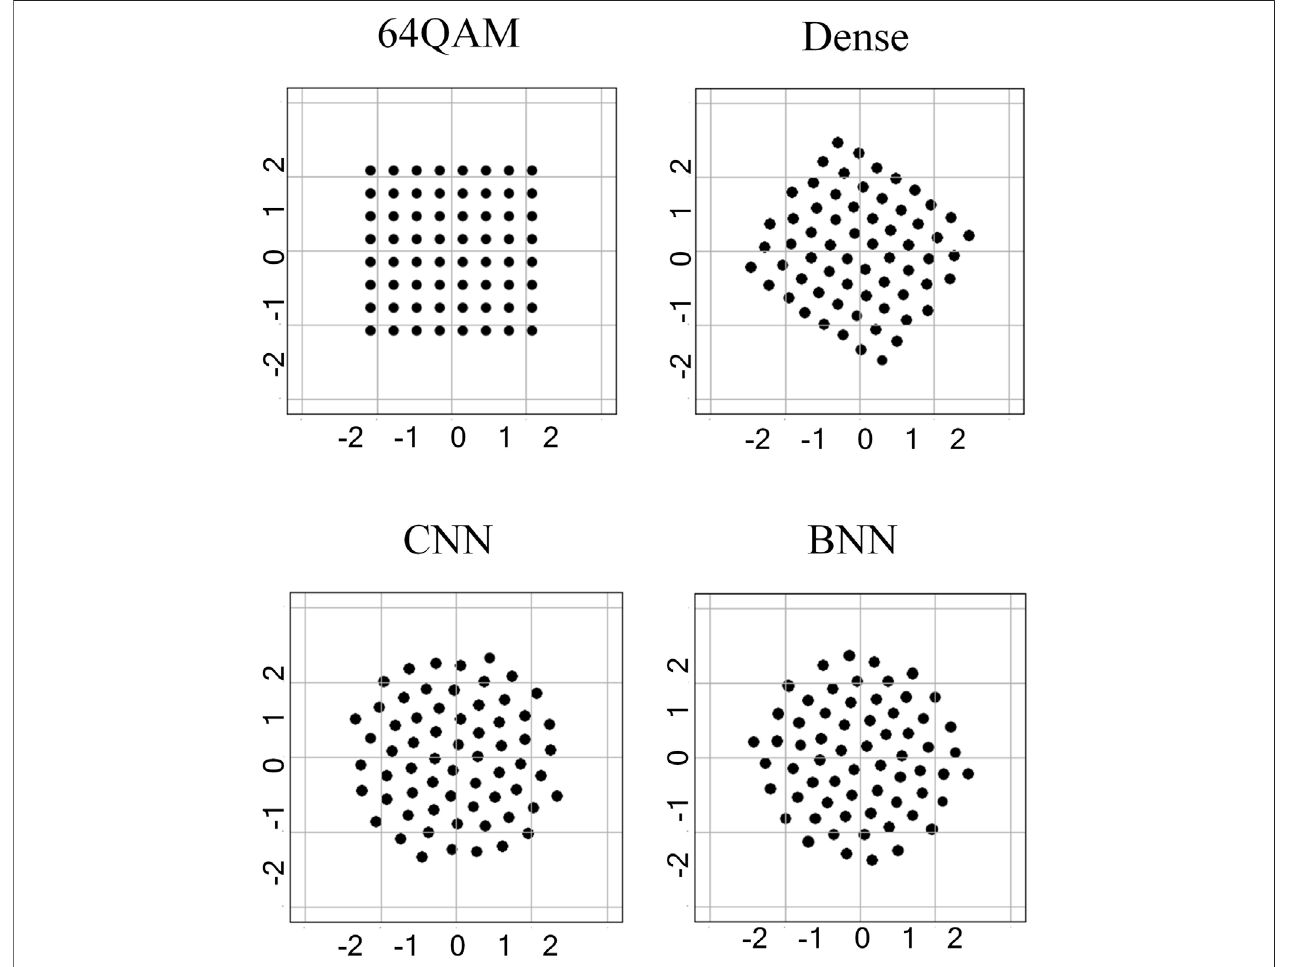
FIGURE 7 | Constellation map under bit.